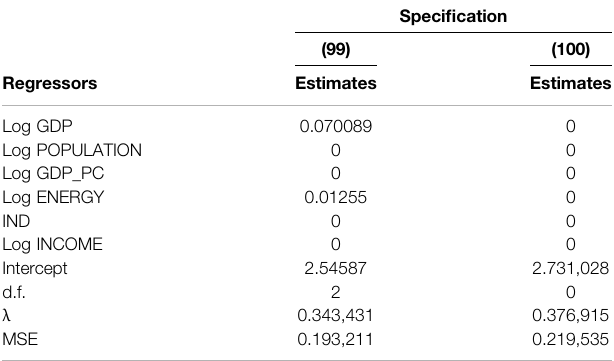
TABLE 3 | LASSO regression results for speci fi cation (99) and (100).